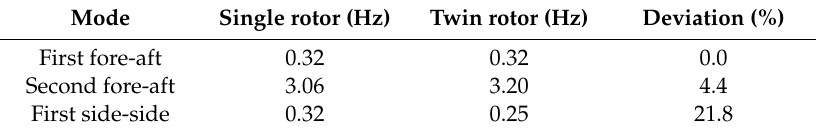
Table 4. Natural frequencies for the tower – Single Vs. Twin rotor configuration.